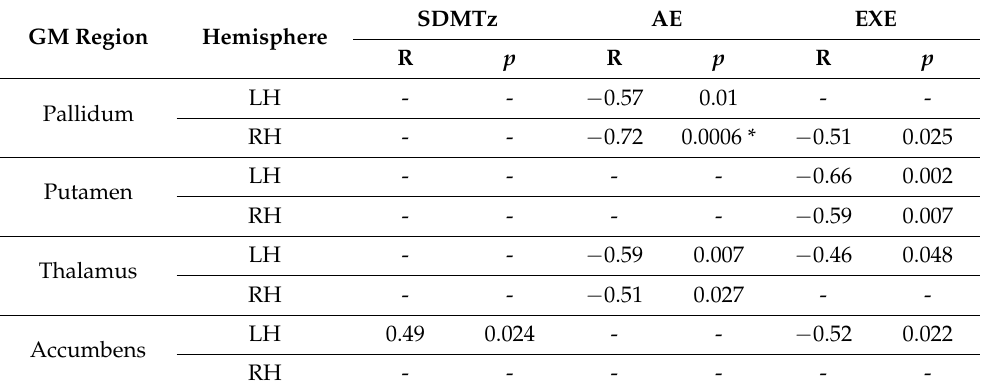
Table 4. Summary of correlation between subcortical GM volumes and normalized Symbol Digits Modality Test (SDMTz) scores, and scores on the Attention Network Tests-Interaction (ANT-I) of alerting (AE) and executive control networks (EXE). Only regions with significant ( p < 0.05) correlation with test scores are